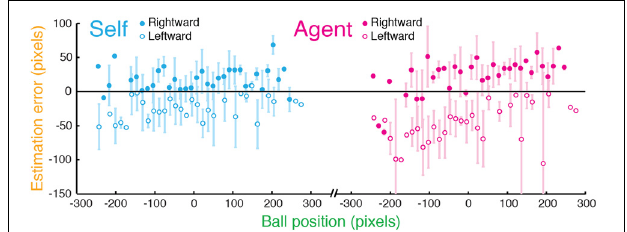
FIGURE 5 | “No Target” task in Experiment 2. The data of a typical participant in the No Target Stop task, in which participants stopped the ball at any time in its sweep (Self) or watched it being stopped by the computer (Agent). Estimation errors are plotted against the ball position (distance from the center of the screen) for when the ball was sweeping in a rightward (filled circles) and a leftward (empty circles) motion. Error bars indicate SD. Estimation errors were not consistently shifted toward a certain point on the screen, but were typically in the direction of the ball’s